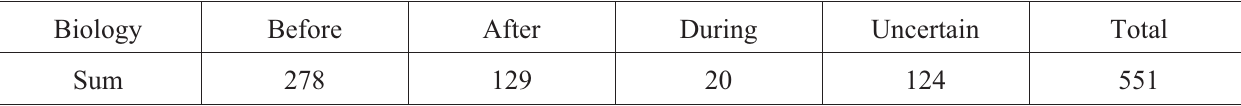
Table 5. Biology